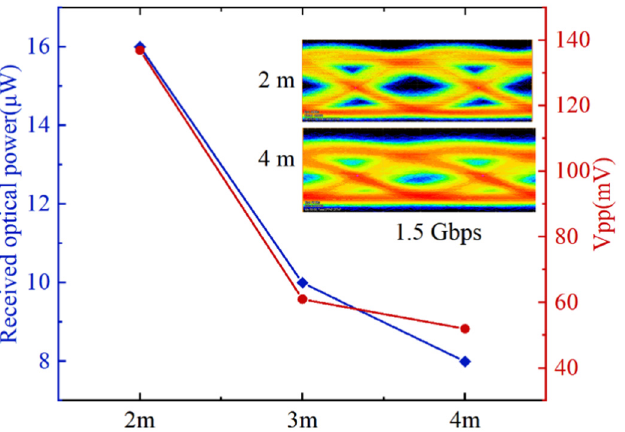
Figure 9. Measured received power and Vpp under the different free-space transmission lengths of 2 m to 4 m (Inset: the eye diagram at the data rate of 1.5 Gbps at 2 m and 4 m).